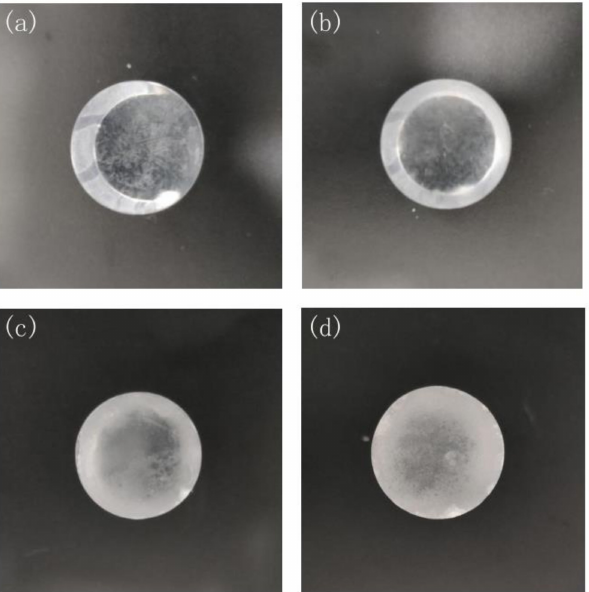
Figure 4. CsI(Na) crystal (size: Φ 25 mm × 50 mm) ( a – d ) exposed to 85% relative humidity air for 0, 2, 4, and 12 h respectively.